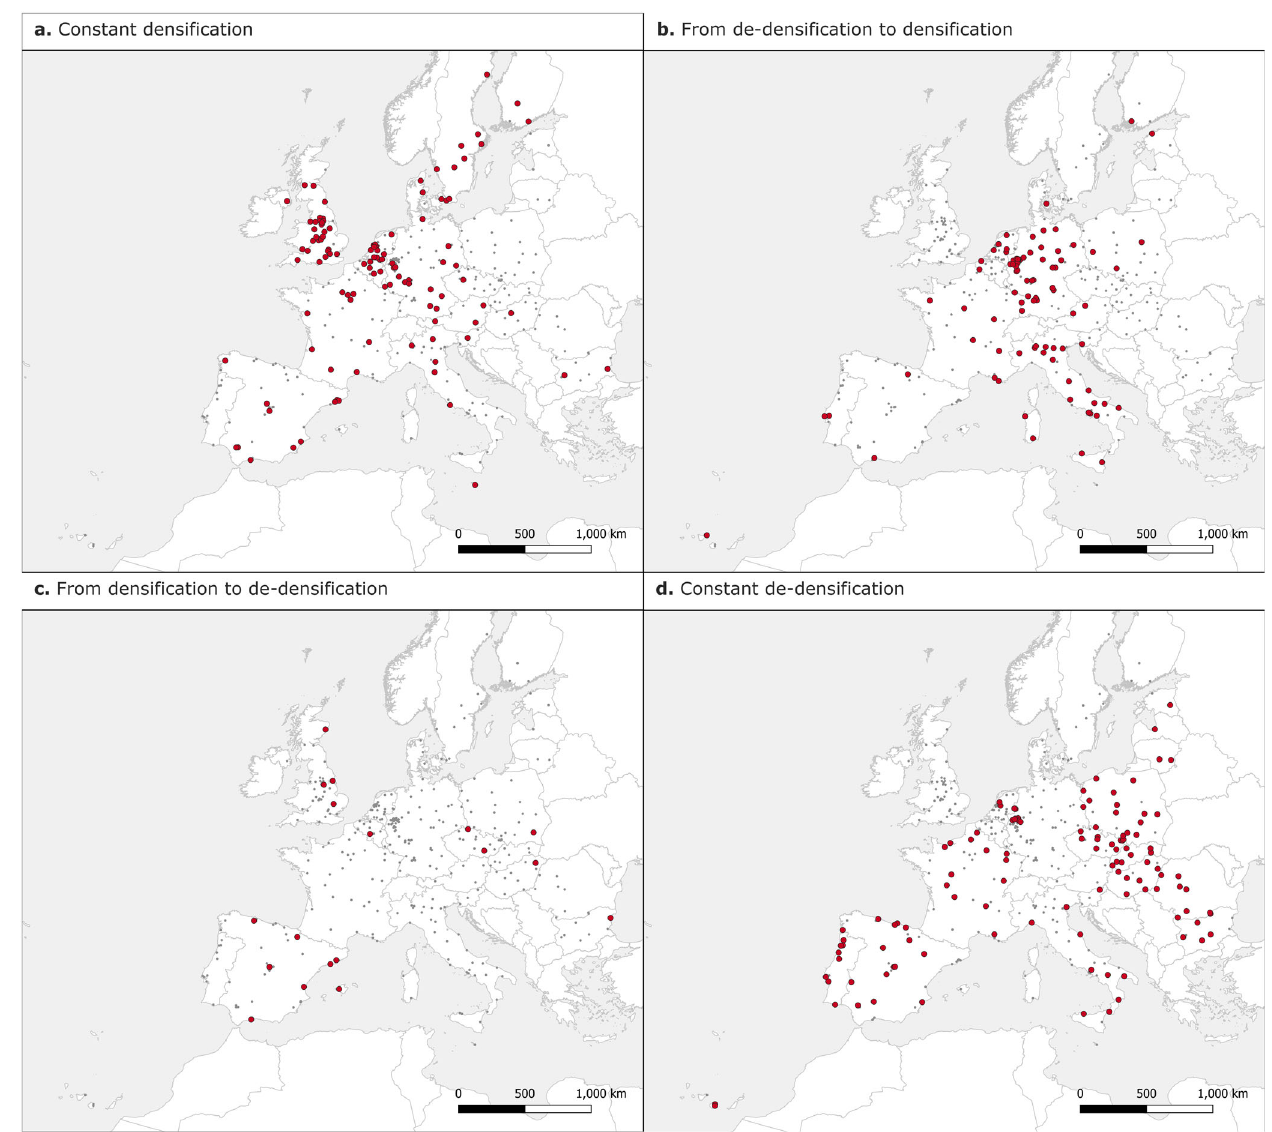
Fig. 3 Density trajectories between 2006 and 2018. Four main density trajectories are identi fi ed by comparing the density trends in 2006 – 2012 and 2012 – 2018: constant densi fi cation ( a ), from de-densi fi cation to densi fi cation ( b ), from densi fi cation to de-densi fi cation ( c ), and constant de-densi fi cation ( d